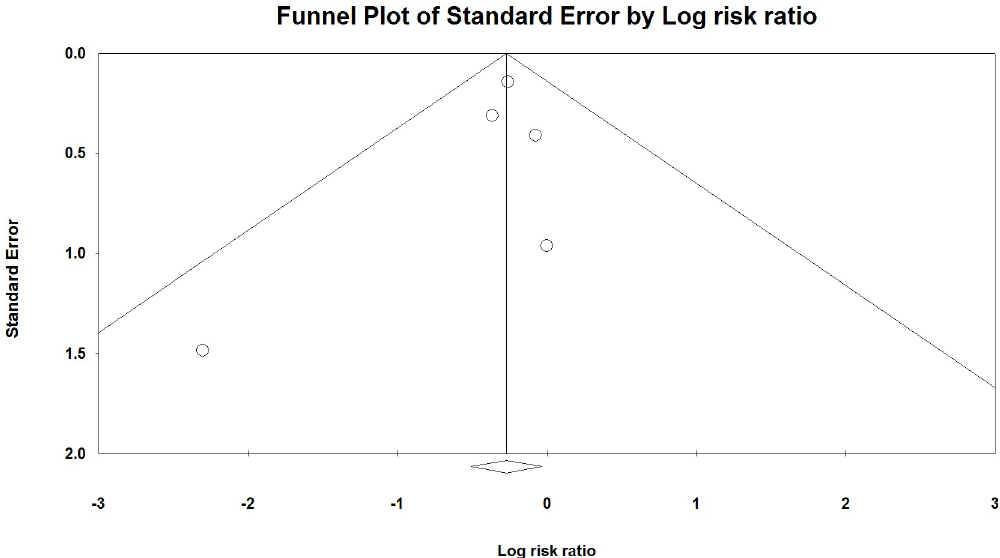
Fig 3. The funnel plot of